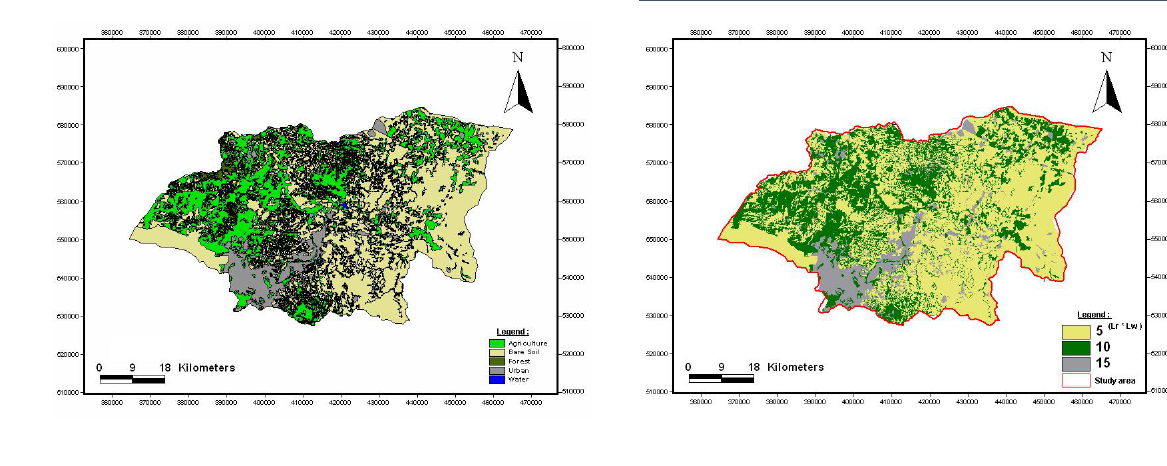
Figure 9. The result of multiplying the land use ( Lr · Lw ) .